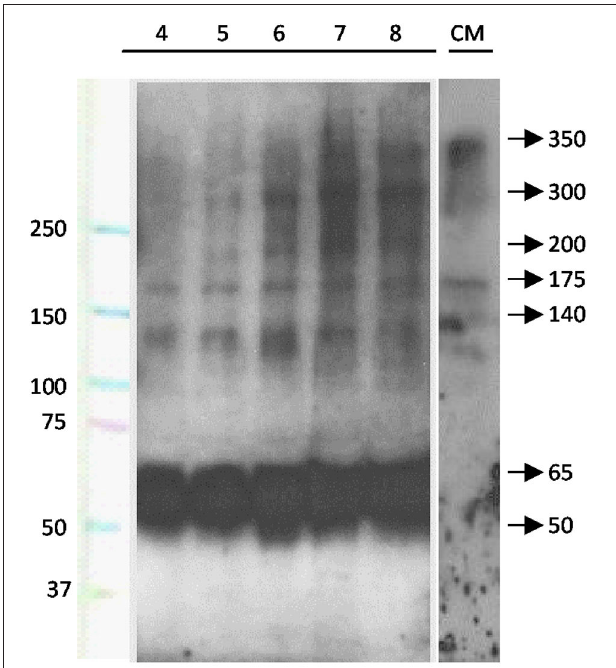
FIGURE 2 | SCO-spondin is present in the eCSF as early as the fourth day of development. Lanes 4–8: western blot analyses performed with anti-SCO-spondin antibody on eCFS extracted from chick embryos at stages comprised between the fourth and eighth day of development (HH23 to HH34). CM: western blot analyses performed with anti SCO-spondin antibody on conditioned medium obtained from HH36 SCO explants cultured in DMEM for four days. Lane 1 indicates molecular weight standards. From the fourth day of development onward, the eCSF contains four AFRU-immunoreactive bands of 175, 140, 65, and 50kDa. Larger bands of 200, 300, and 350kDa appear progressively during the subsequent days. Note the presence of the 140 and 175, 200, 300, and 350kDa bands in the conditioned